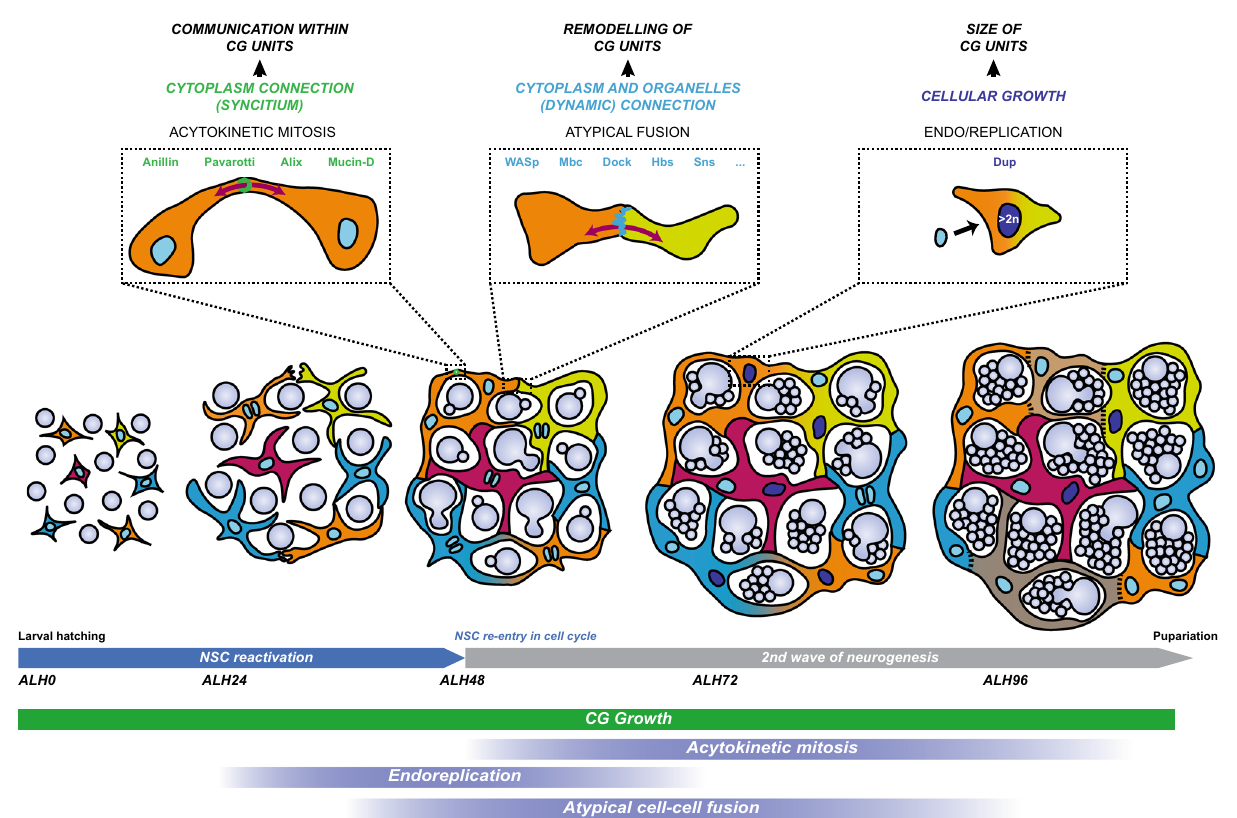
Fig. 10 | Model of CG morphogenesis along developmental time and NSC behaviour. Individual CG cells grow to tile the CNS, undergoing both endor- eplicative and mitotic events that create multinucleated and polyploid cells. Endoreplication, covering both endocycle and endomitosis, implies the lack of nuclear division and results in polyploid nuclei. In contrast, acytokinetic mitosis displaysallstagesofmitosis includingmidbodyformation, butwithoutabscission, andproducesbrothernucleithatwillsharethesamecytoplasmthroughremaining